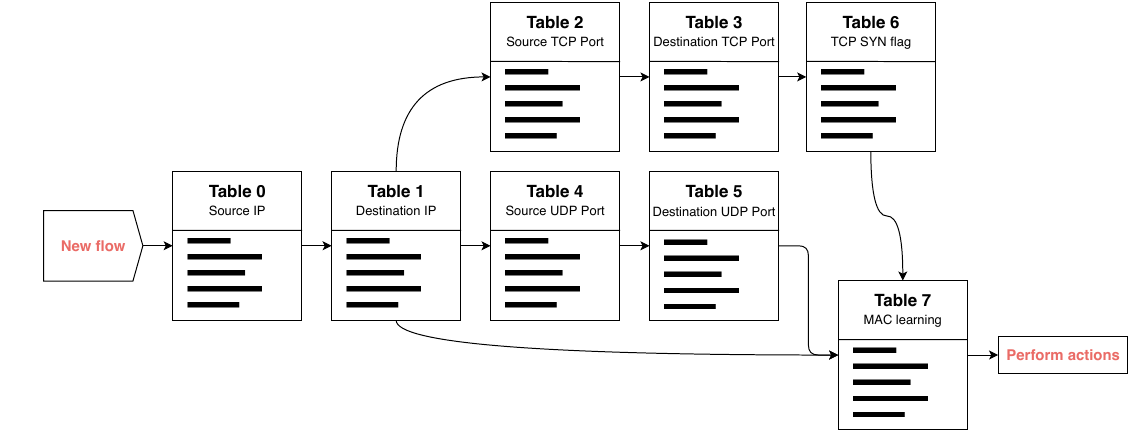
Figure 9. Pipeline for new flows in the state